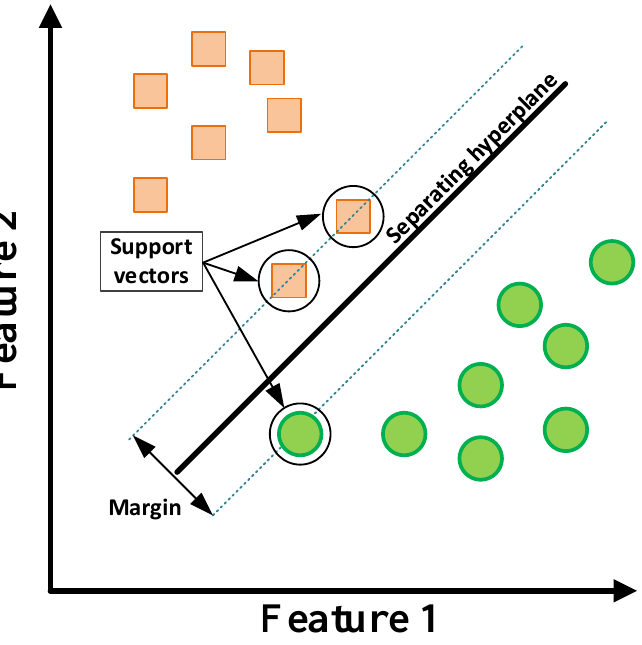
Figure 13. SVM classification principle.